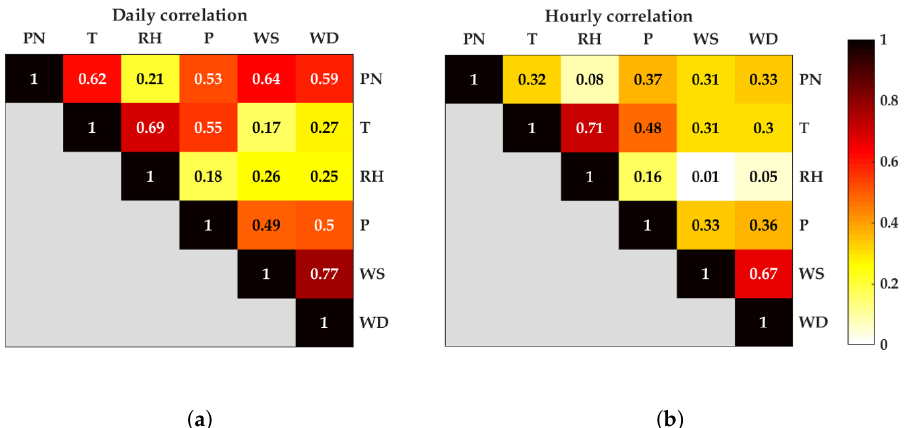
Figure 6. Matrix plots: absolute Pearson correlation coefficients between measured variables for daily and hourly averaged data. ( a ) Daily. ( b )